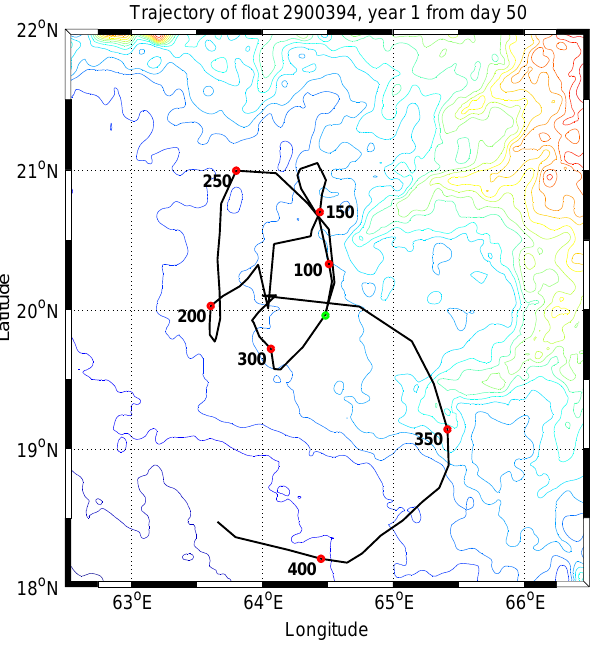
Fig. 22. Trajectory of float 2900394, for year 1 from day 50, super- Figure 22: Trajectory of float 2900394, for year 1 from day 50, superimposed on imposed on bathymetry. A green dot indicates the initial position of bathymetry. A green dot indicates the initial position of the float; red dots mark the float; red dots mark the position of the float every 50 days. the position of the float every 50 days. Clearly, if a strong correlation between surface and deeper motions could often be established at 100–200 km scale, loops with 30–40 km diameter, performed by the floats were not sampled by altimetry, due to its resolution. Some of these small loops could be correlated with thermohaline anomalies at the same scale and at the depth of PGW or of RSOW. The float trajectories also reflected the large-scale wind-induced